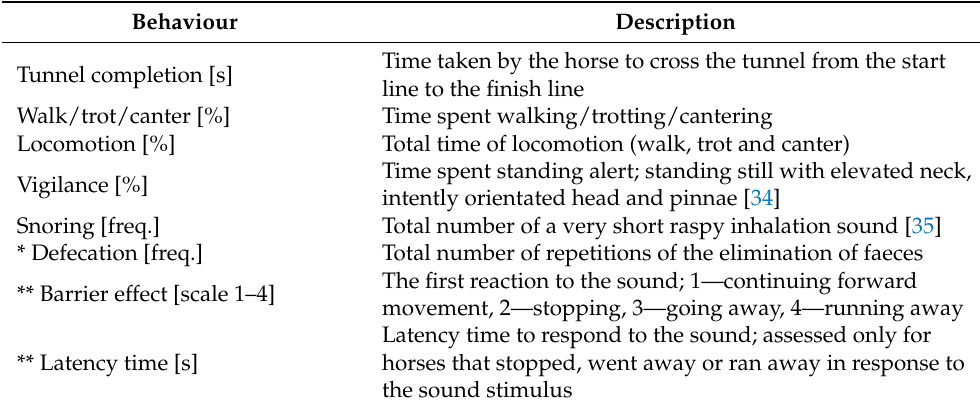
Table 2. Behaviours assessed during stages B and C of each test variant (F,